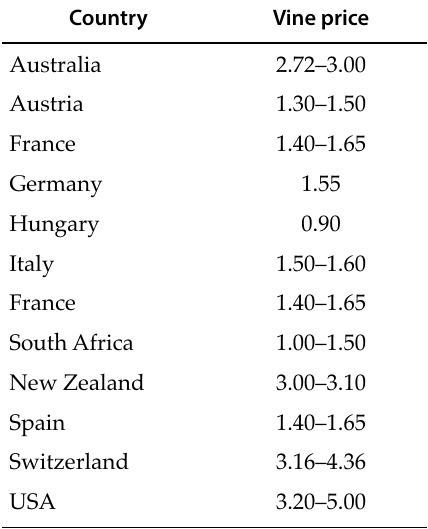
Table 1. Prices (Euros, as at June 2017) of grapevine root- stock cuttings and bare rooted grafted vines in different countries. Prices may vary depending on variety and